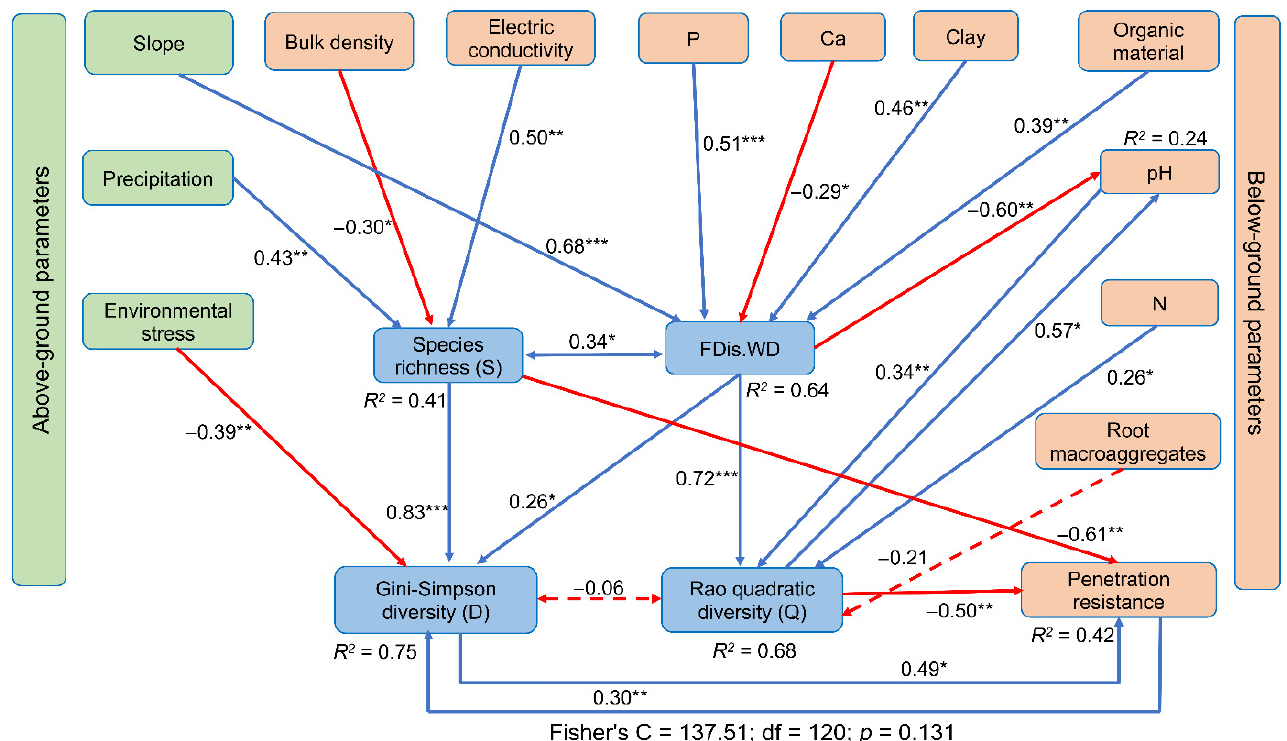
Figure 6. Structural equation model (SEM) selected for the effects of above- and below-ground environmental parameters (green and orange rectangles, respectively) on taxonomic (S and D) and functional (FDis.WD and Q) diversity (both, blue rectangles). Functional dispersion of wood density (FDis.WD). Blue solid arrows represent significant and positive effects, while red solid arrows indicate significant and negative effects. Dashed arrows indicate no significant effects. Blue double-headed solid arrows represents significant and positive residual covariance, while red double-headed dashed arrows denote no significant residual covariance. Values adjacent to the arrows correspond to the standardized coefficients. Individual R 2 indicate the proportion of variance explained for response variable. Global goodness-of-fit test based on Fisher’s C statistic. *, **, and *** indicate p < 0.05, p < 0.01, and p < 0.001,